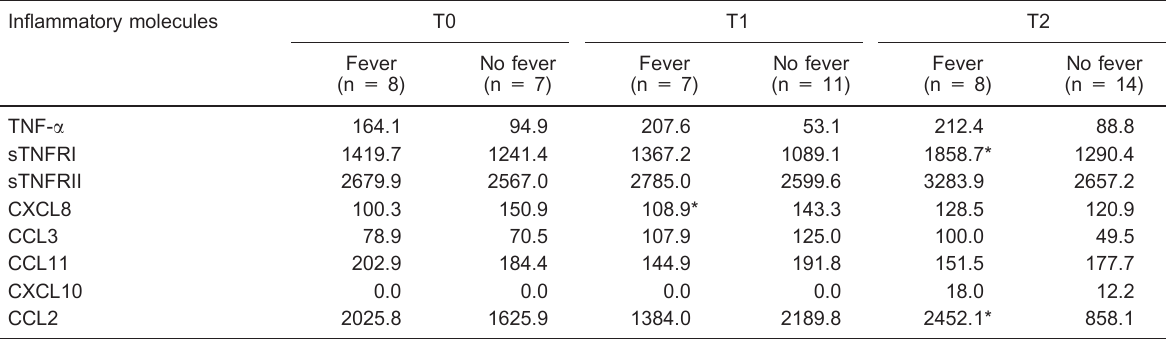
Table 4. Dynamic behavior of the different plasma inflammatory molecule levels in neutropenic patients not undergoing transplantation with fever or not. Inflammatory